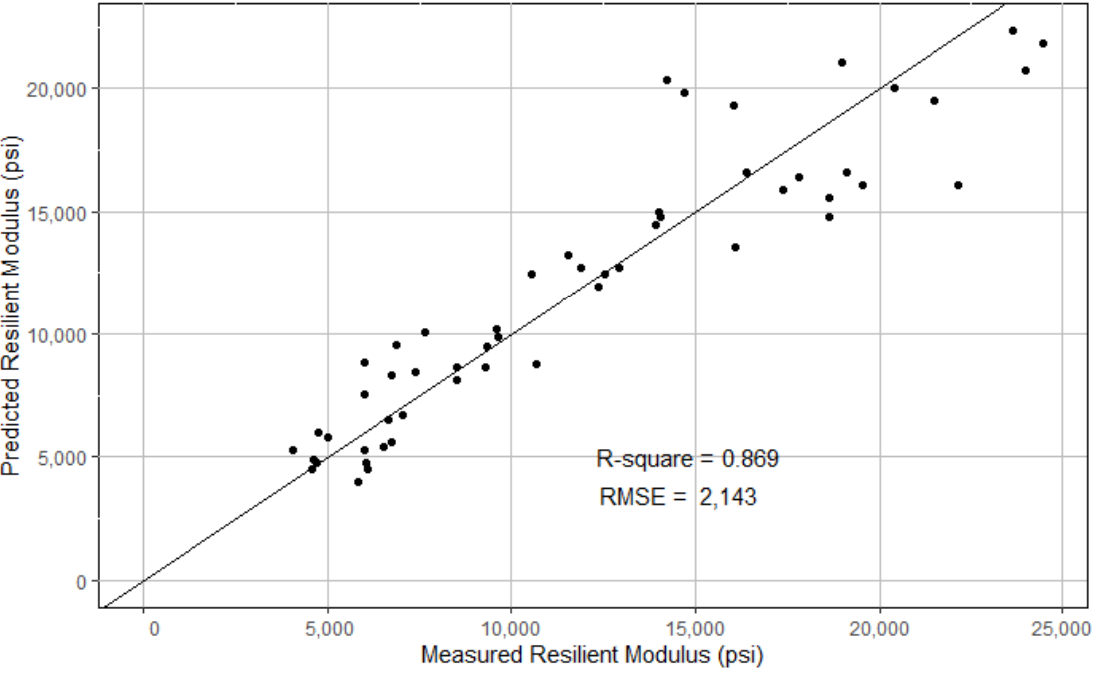
Figure 11. Predicted M R versus measured M R on testing dataset (the MLR model).